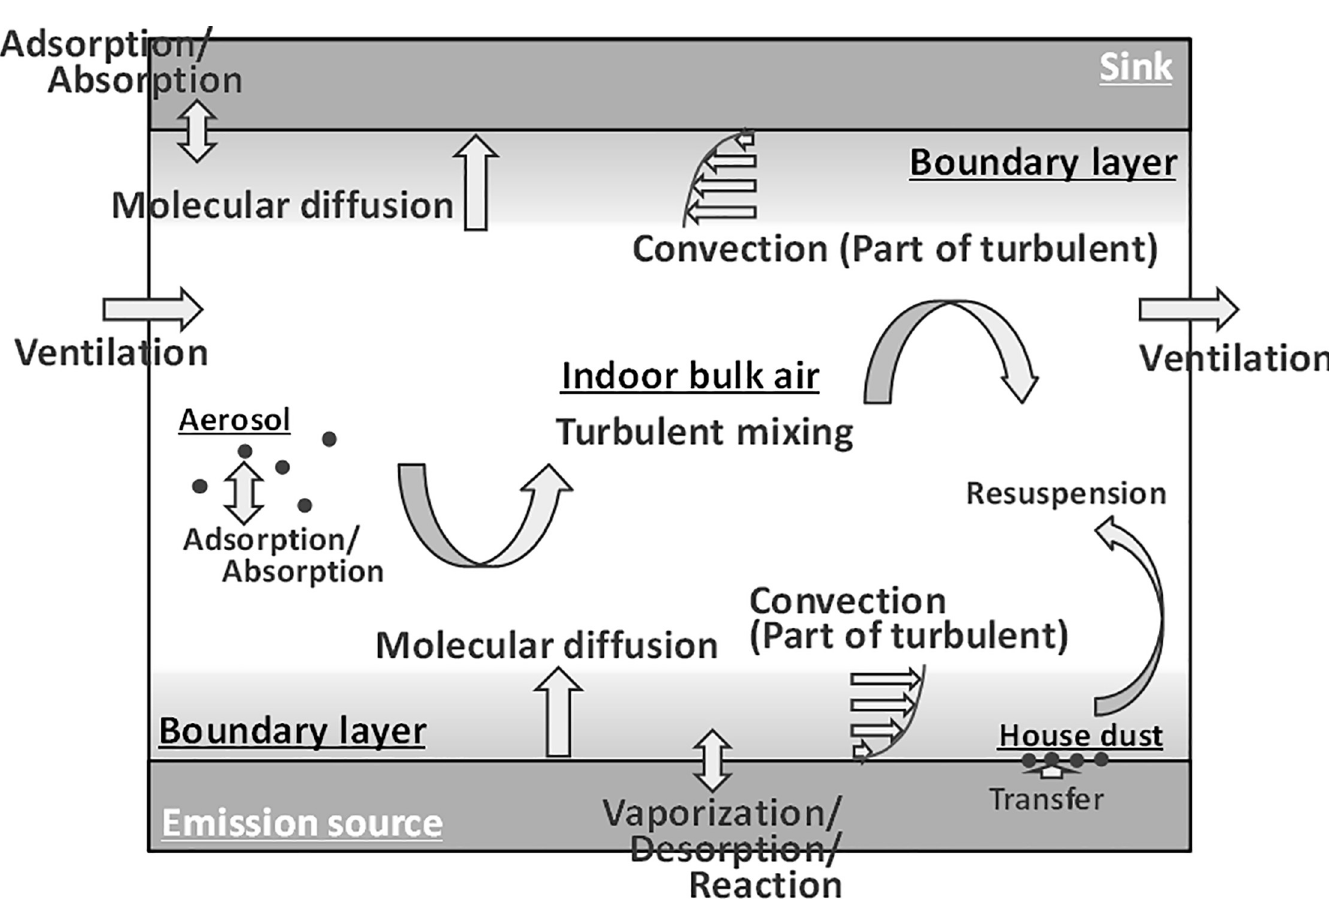
Fig 1. Schematic representation of semi-volatile organic compounds (SVOCs) in an indoor